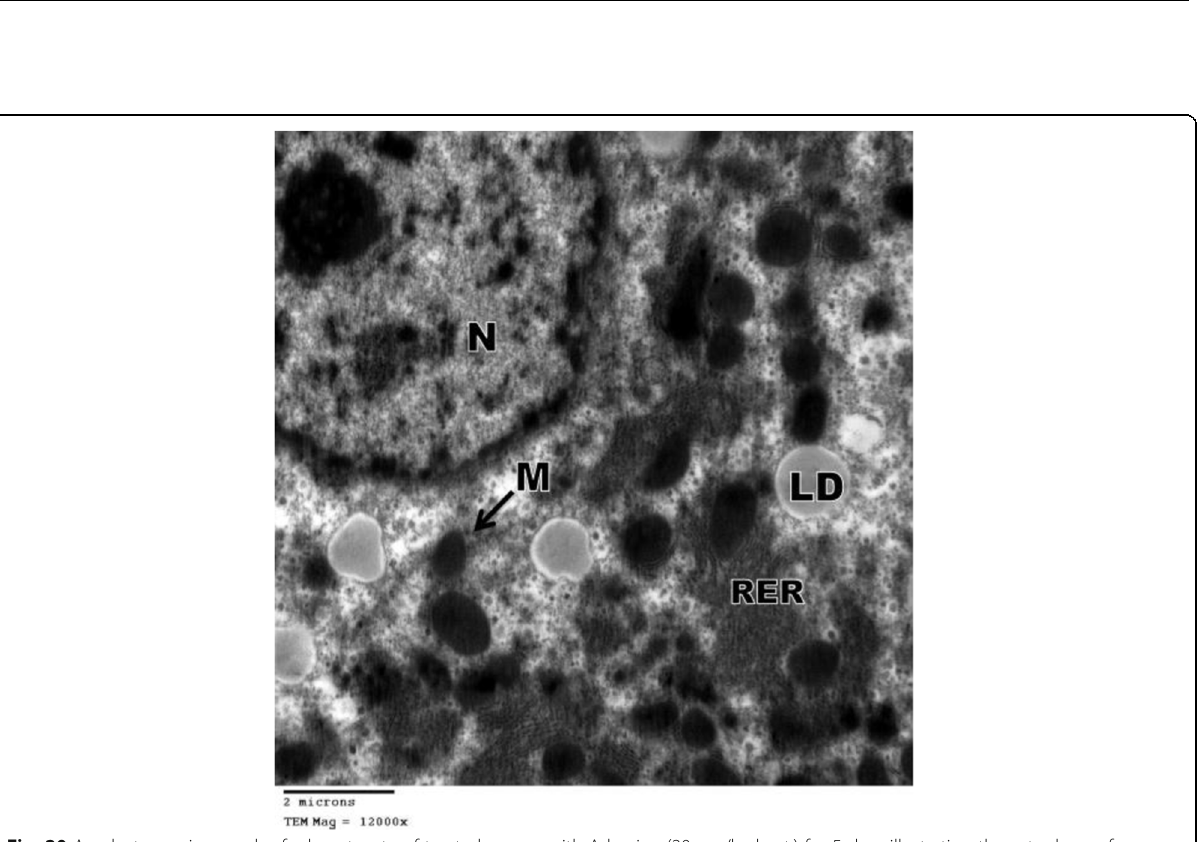
Fig. 20 An electron micrograph of a hepatocyte of treated mouse with Adamine (20 mg/kg b.wt.) for 5 days illustrating the cytoplasm of hepatocyte possesses lipid droplets (LD), rough endoplasmic reticulum (RER), condensed mitochondria (M), and part of nucleus (N) is also seen. (×